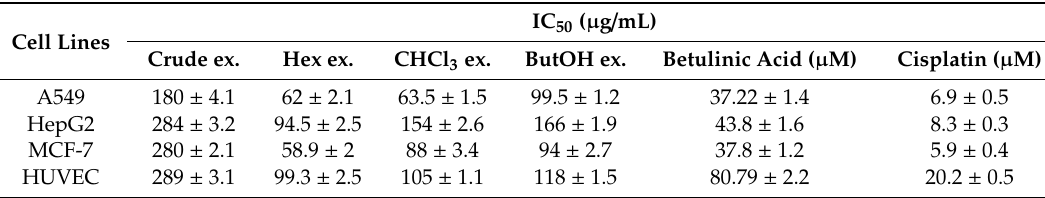
Table 2. IC 50 values for the L. acacia crude extract and fractions.